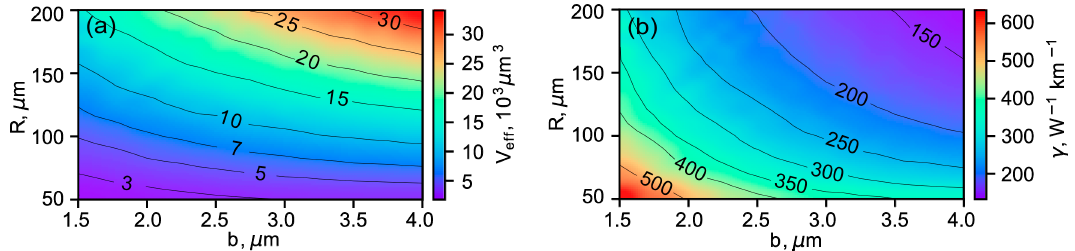
Figure 4. Effective volume of fundamental WGM ( a ) and nonlinear coefficient ( b ) as functions of Figure 4. E ff ective volume of fundamental WGM ( a ) and nonlinear coe ffi cient ( b ) as functions of thickness and radius of a microbubble calculated at λ p = 3.5 μ m. thickness and radius of a microbubble calculated at λ p = 3.5 µ m.